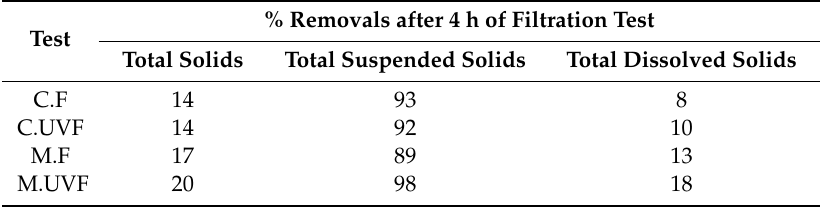
Table 3. Removals of total solids, total suspended solids and total dissolved solids after 4 h of